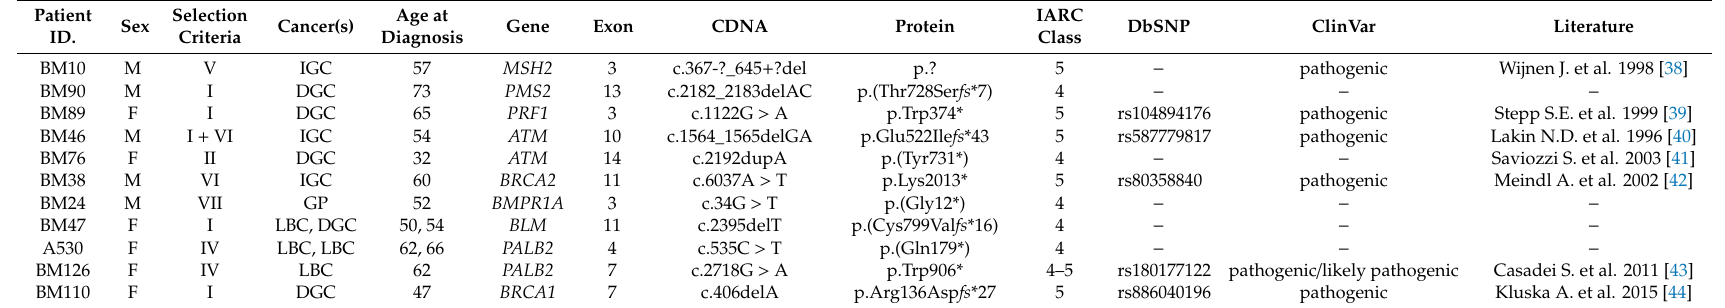
Table 3. Carriers of deleterious variants in cancer-related